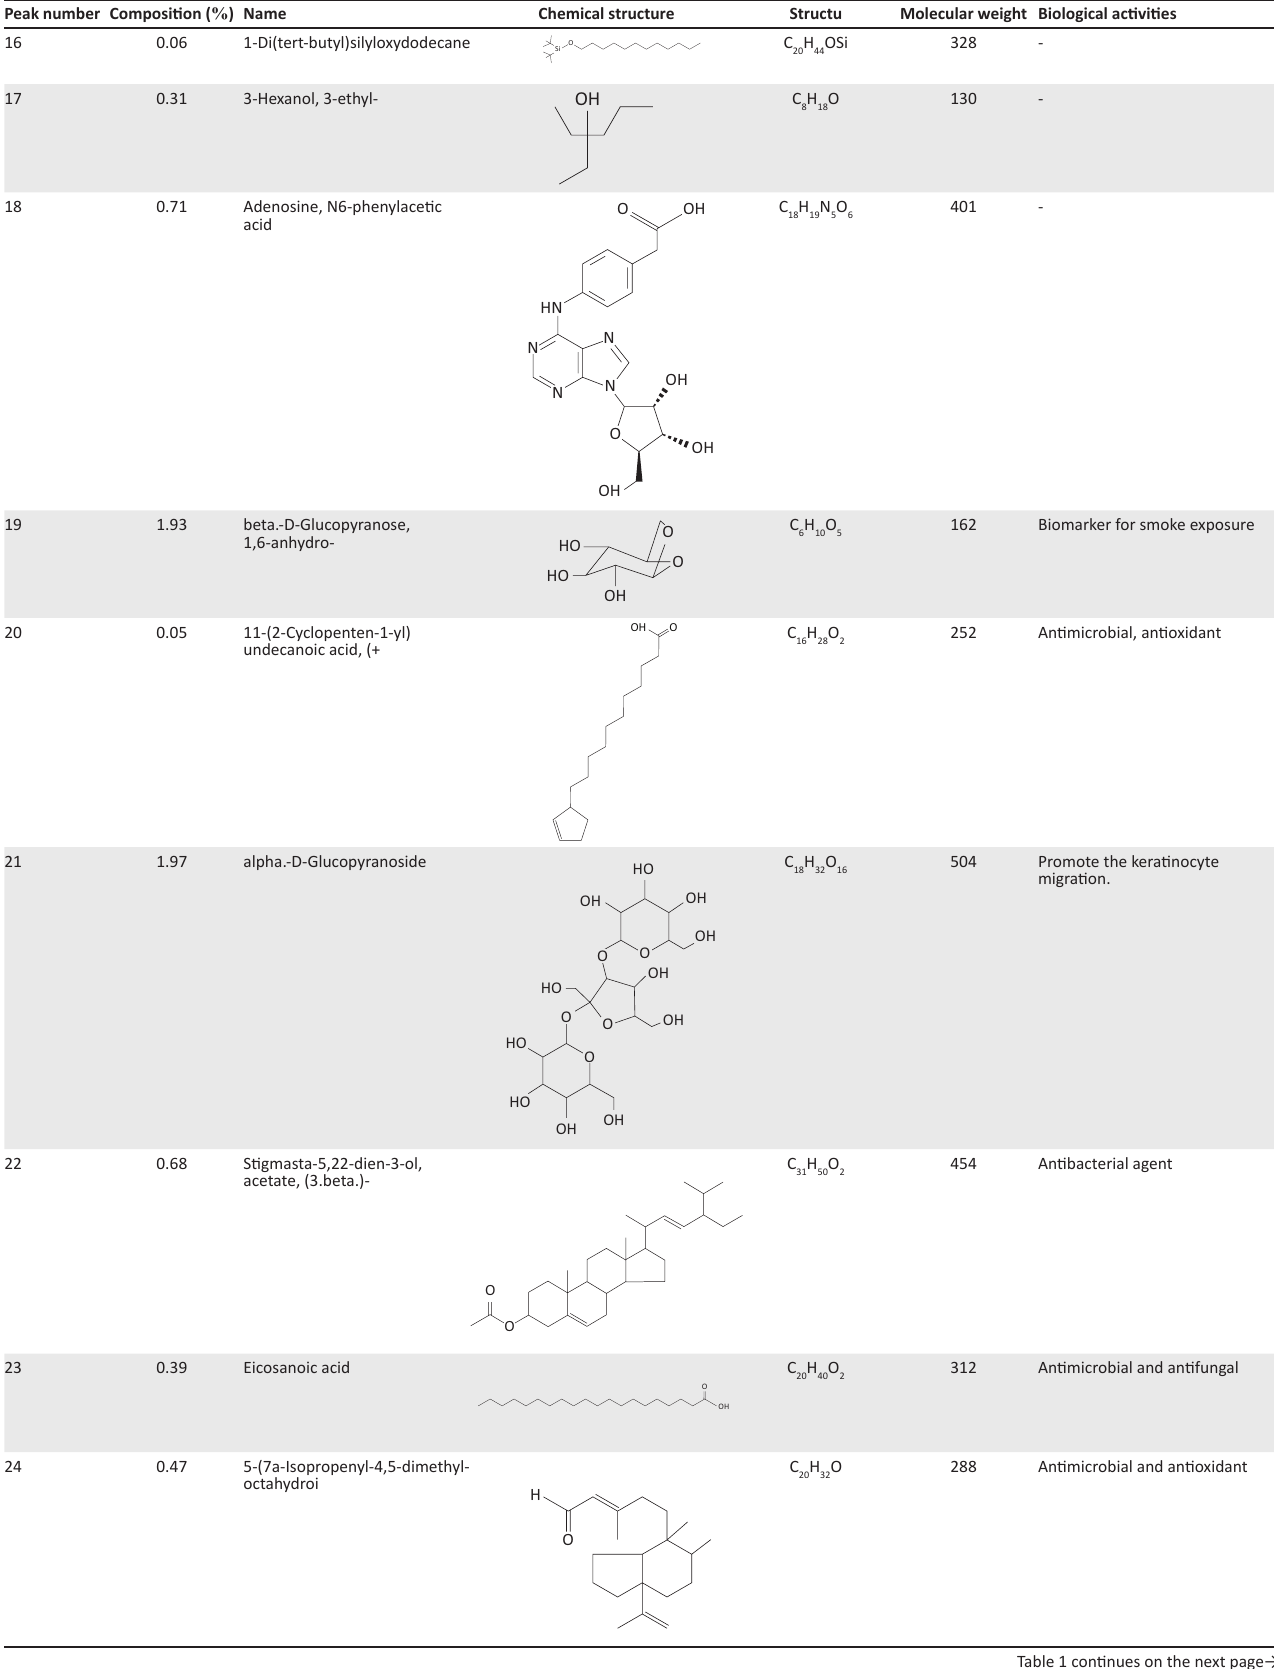
TABLE 1 (Continues...): Chemical compounds in ethylacetate extract of Adansonia digitata identified by gas chromatography–mass spectrometry. Peak number Composition ( % )